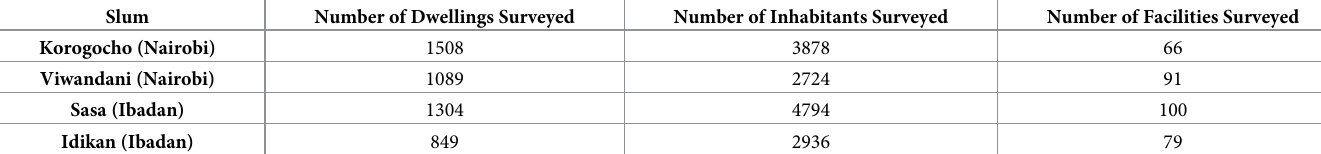
Table 1. Data summary of surveys collected by